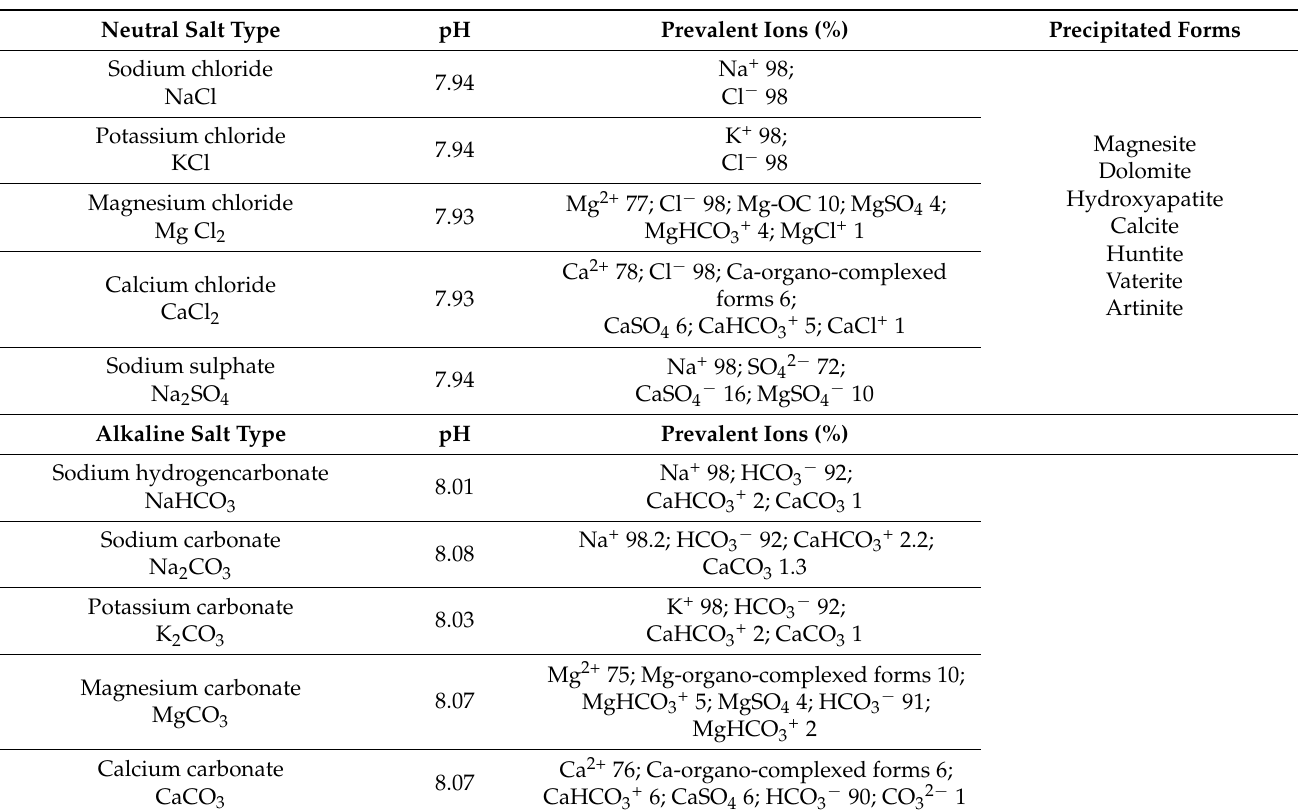
Table 1. Chemical speciation reactions for widely studied neutral and alkaline salt types dissolved in rhizosphere solution (after